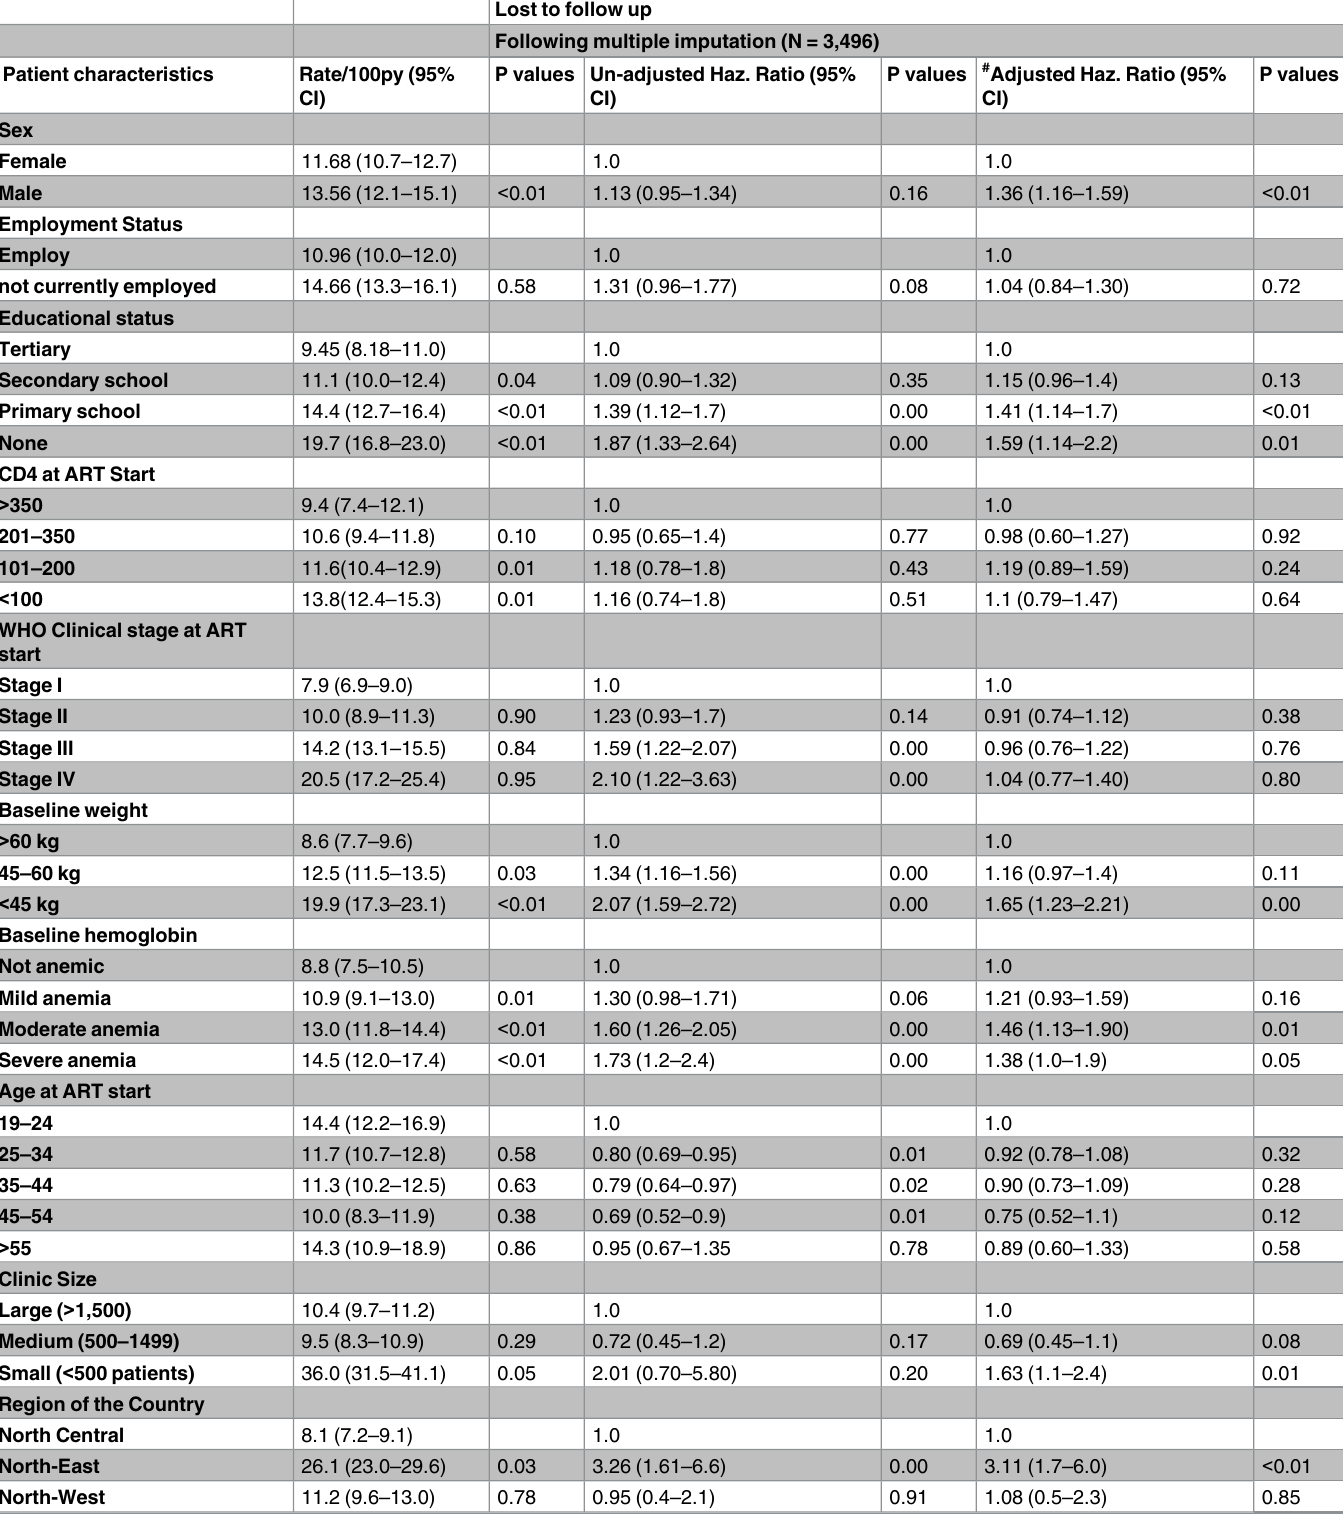
Table 3. Patient characteristics at antiretroviral therapy initiation associated with LTFU.